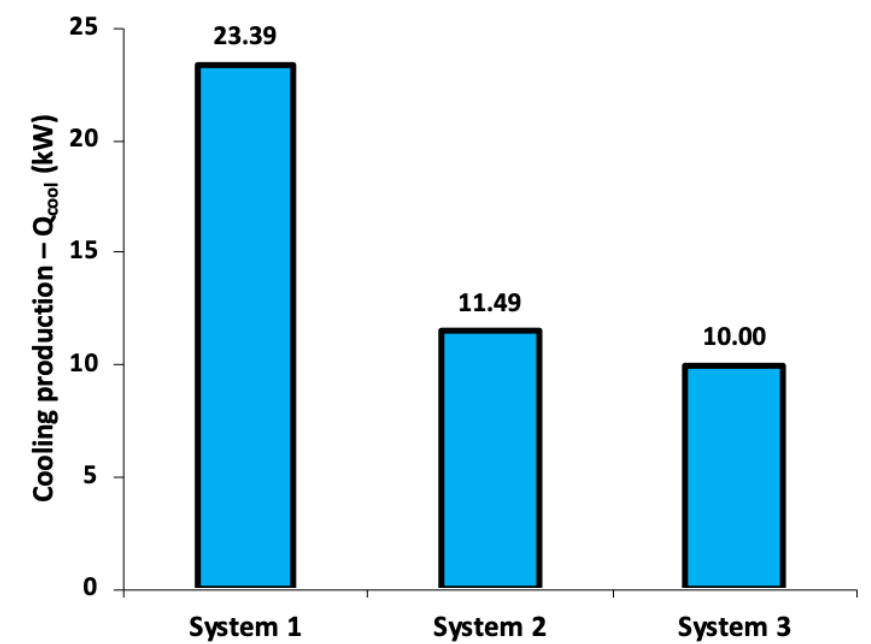
Figure 15. Cooling production of the examined systems. Table 5. Summary of the final results for the examined systems.